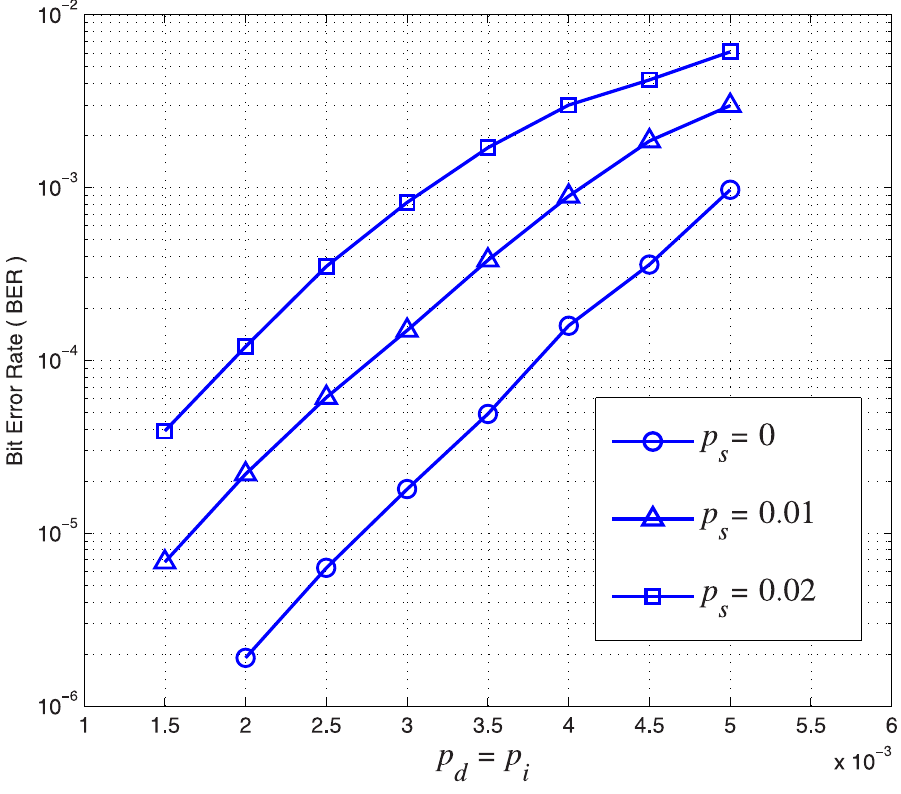
Fig 7. BER of the concatenated LDPC-marker code over the CID channel. N c = 18 and N m = 2.